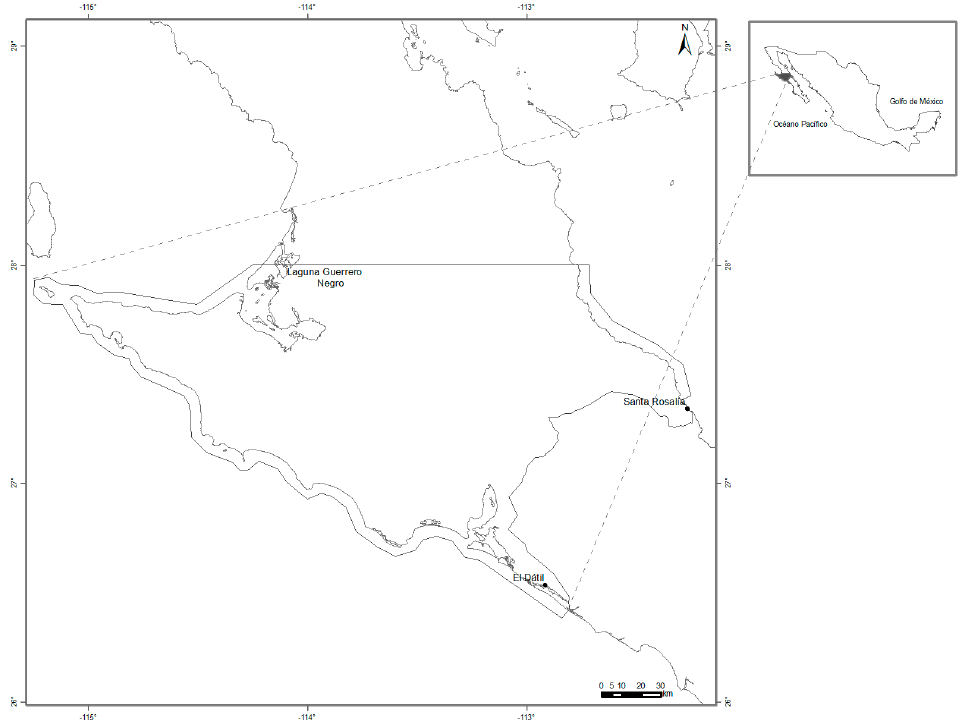
Figure 1. Area of Biosphere Vizcaino Reserve.